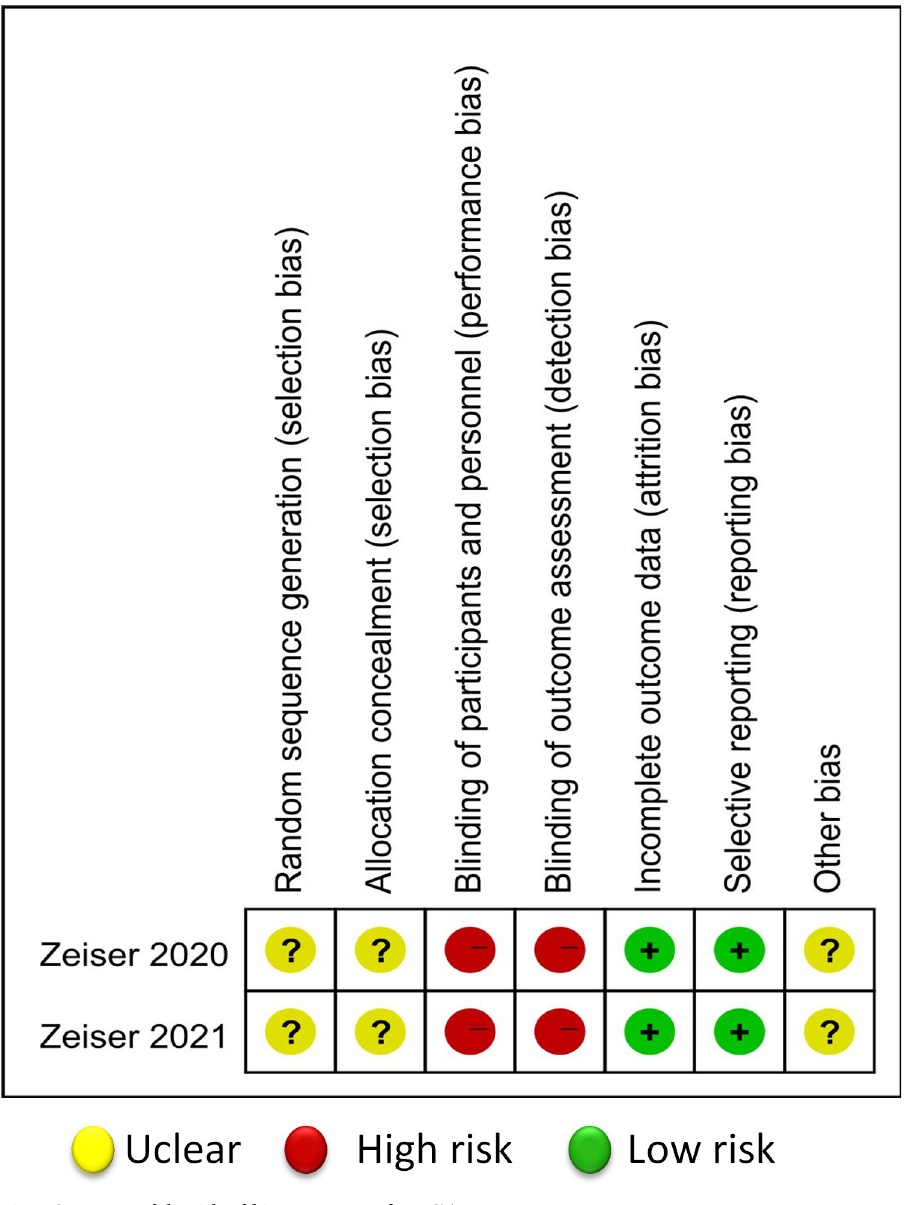
Fig 2. Summary of the risk-of-bias assessment for